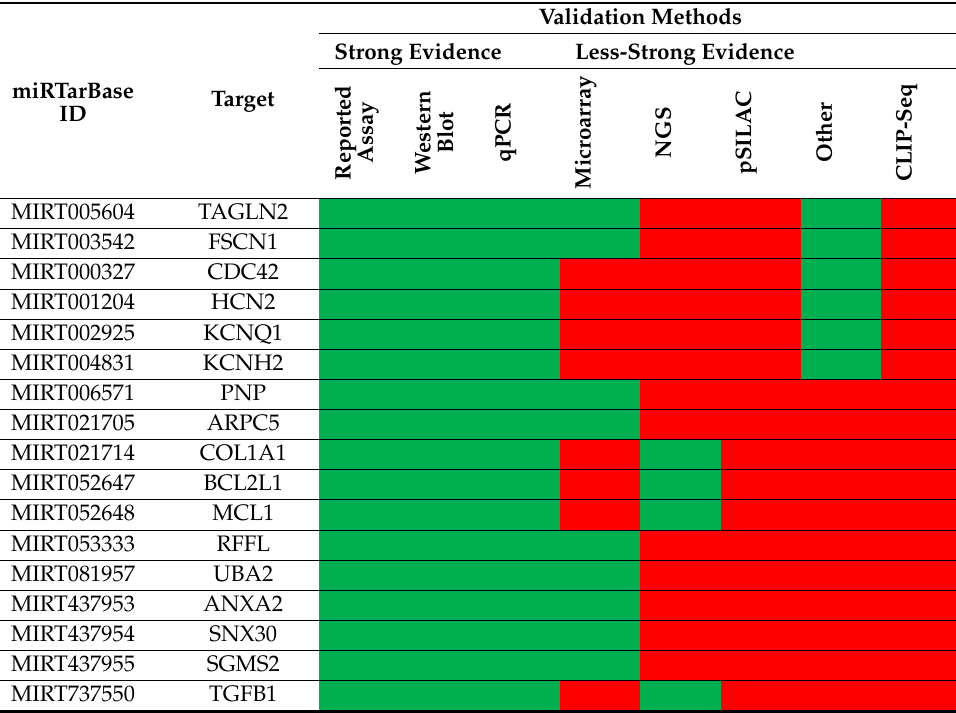
Table 3. Summary of the miRNA interactions referred to hsa-miR-133a-3p, supported with at least 4 positive tools; green = validated methods, red = unvalidated methods. The methods are distinguished as strong or less-strong